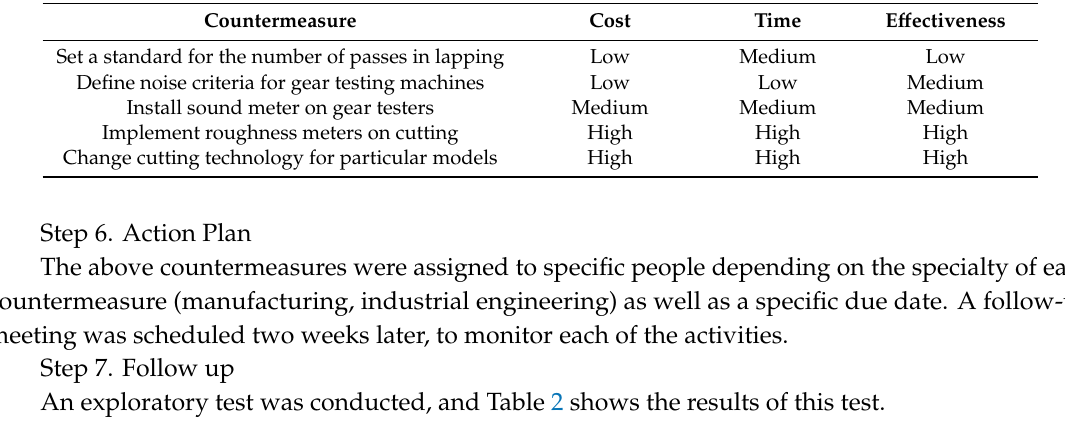
Table 1. Countermeasures